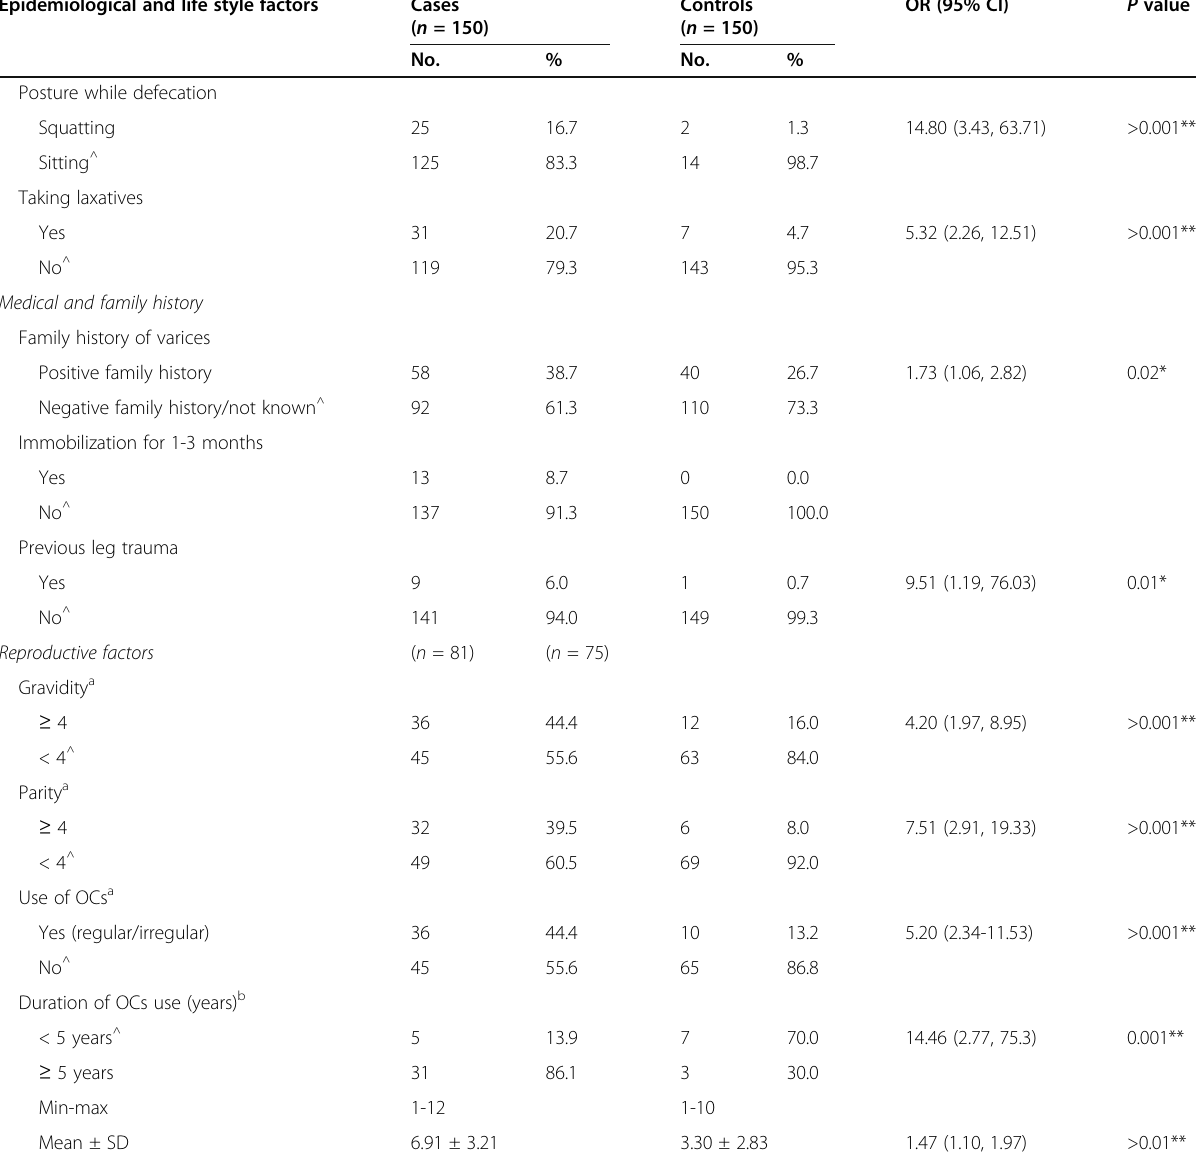
Table 2 Epidemiological and life style factors associated with lower limbs varicose veins (LLVV) (Continued) Epidemiological and life style